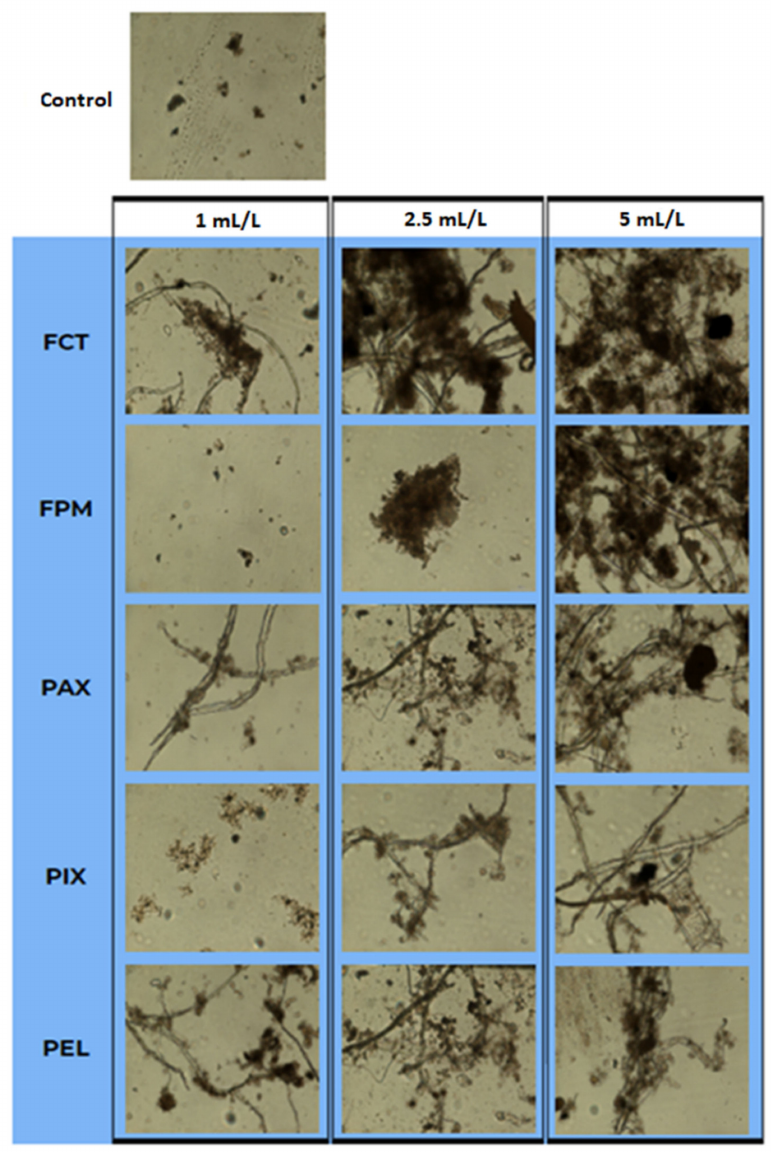
Figure 4. Microscopic analysis of solids from the sludge phase depending on the type and dose of C/Fs. In all cases, the addition of C/Fs to wastewater changed the pH value (Figure 5). The change in pH value towards alkaline was noted for FCT and PEL. FPM and PIX decreased responses by maximum 0.50 and 0.54 pH units, respectively. The dose of 1.0 mL PAX/L increased the pH value; the other doses resulted in its